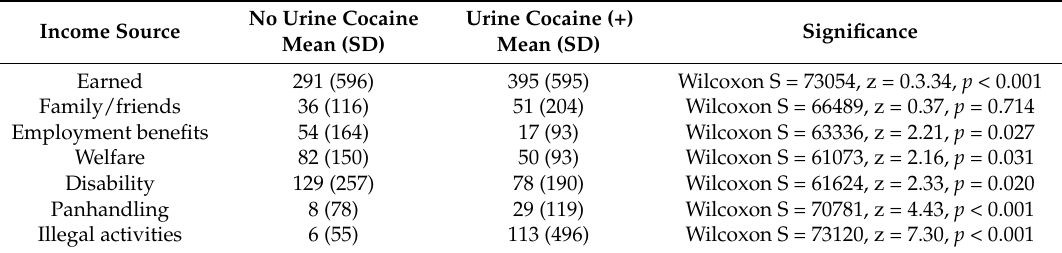
Table 8. Amounts earned from various 30-day income sources among those with and without 30-day drug expenditures in the same month.